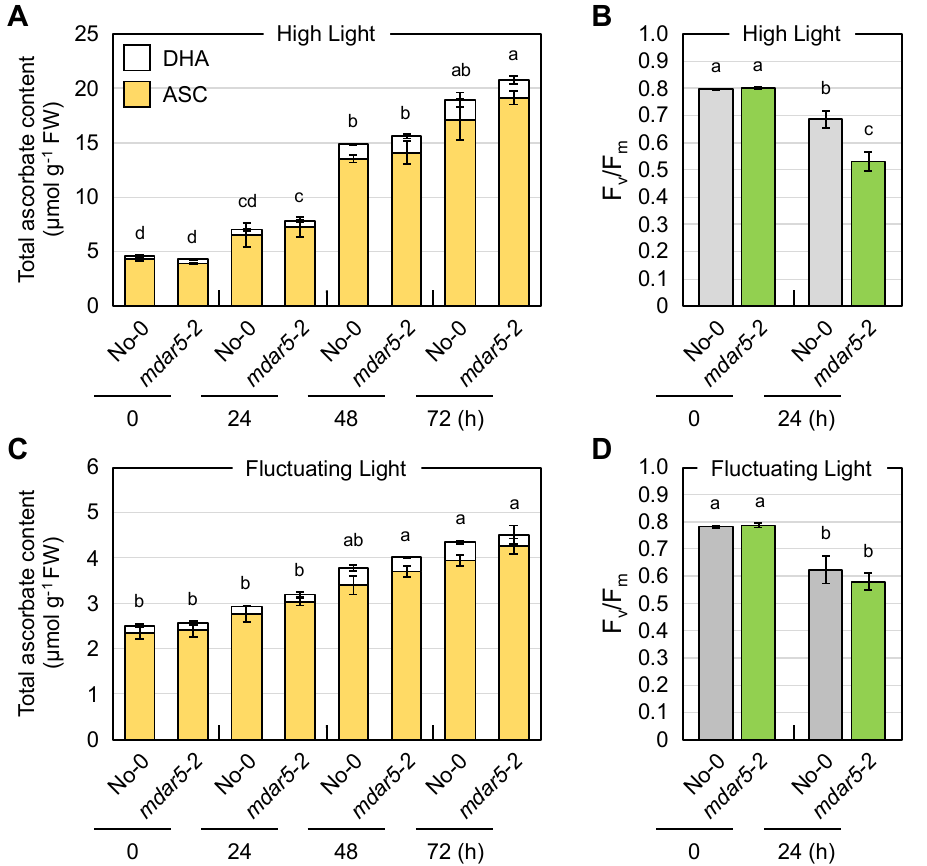
Figure 4. The impacts of AthMDAR5 on the foliar ascorbate profile under light stress conditions. Arabidopsis thaliana wild-type (No-0) and mdar5-2 plants were grown in soil under normal light (100 µ mol photons m − 2 s − 1 ) conditions for 25 days and then exposed to ( A , B ) high ( A , C ) The total ascorbate content (the sum of the reduced and oxidized forms) in the leaves was measured. The ascorbate redox state (the ratio of the reduced form to the total content) is shown in Table S3. ( B , D ) The maximum quantum yield of photosystem II (F v /F m ) was measured before and after stress. Data are presented as the mean ± SE of at least three biological replicates. Different letters indicate significant differences ( p < 0.05, Tukey–Kramer test). ASC, reduced ascorbate; DHA, dehydroascorbate (oxidized